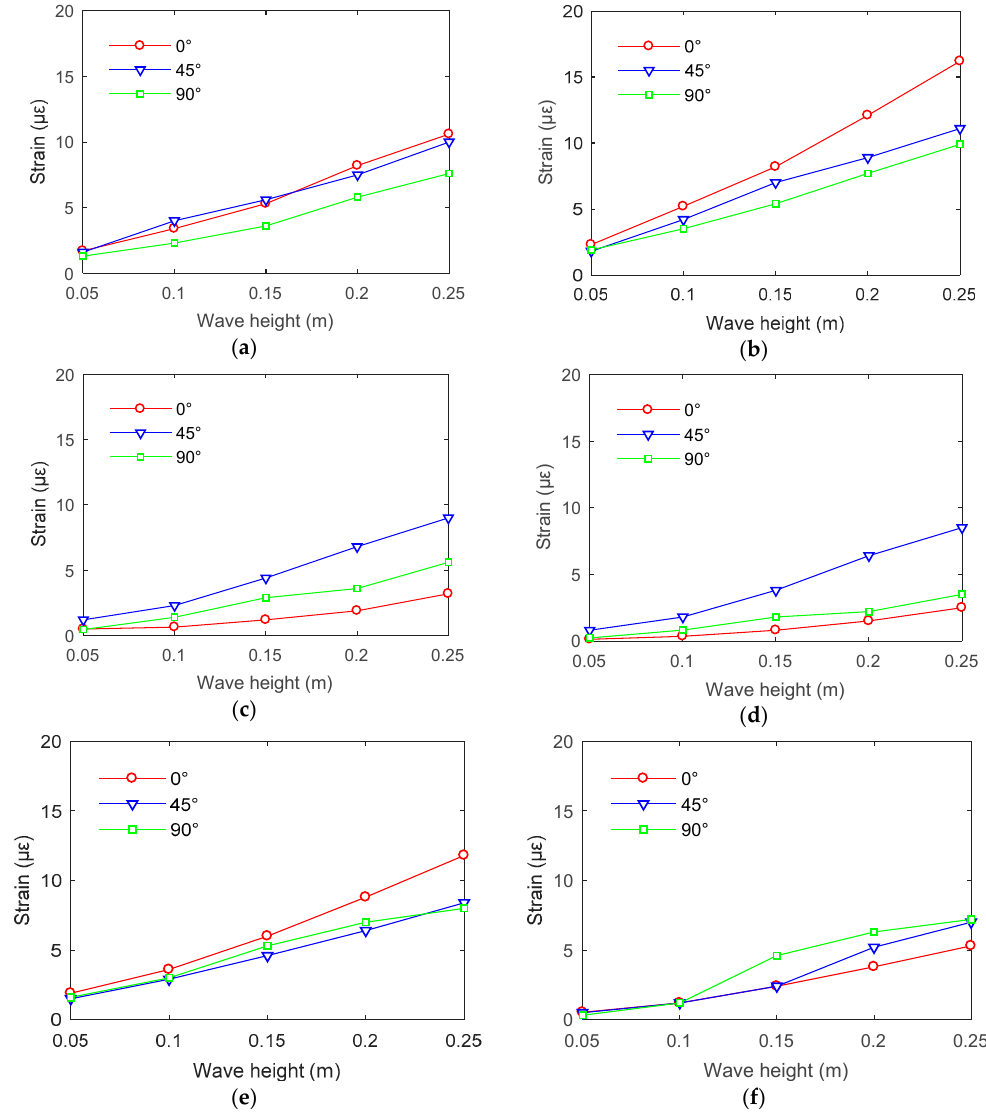
Figure 16. Structural strain responses at various measurement positions of the electrical platform with various attack angles in waves for wave period of 1.6 s. ( a ) S1; ( b ) S2; ( c ) S3; ( d ) S4; ( e ) S5; ( f )